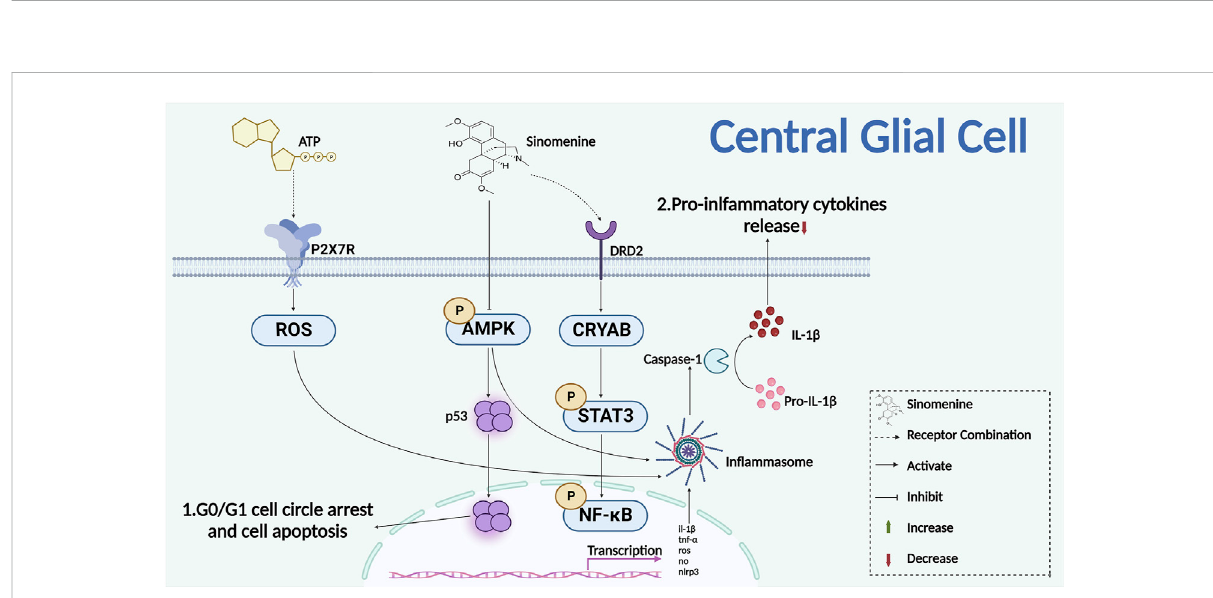
FIGURE 6 Sinomenine inhibits the proliferation of glial cells and the release of in fl ammatory cytokines.